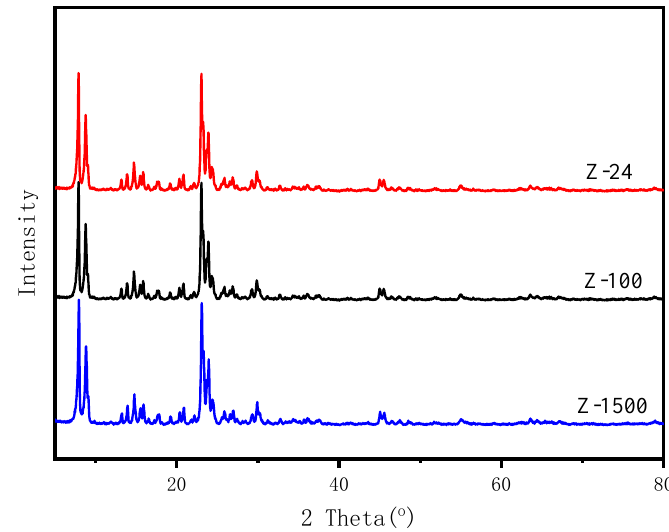
Figure 3. The XRD patterns of the zeolites with different molar ratios of Si/Al. The texture parameters of ZSM-5 zeolites with different SiO 2 /Al 2 O 3 molar ratios are listed in